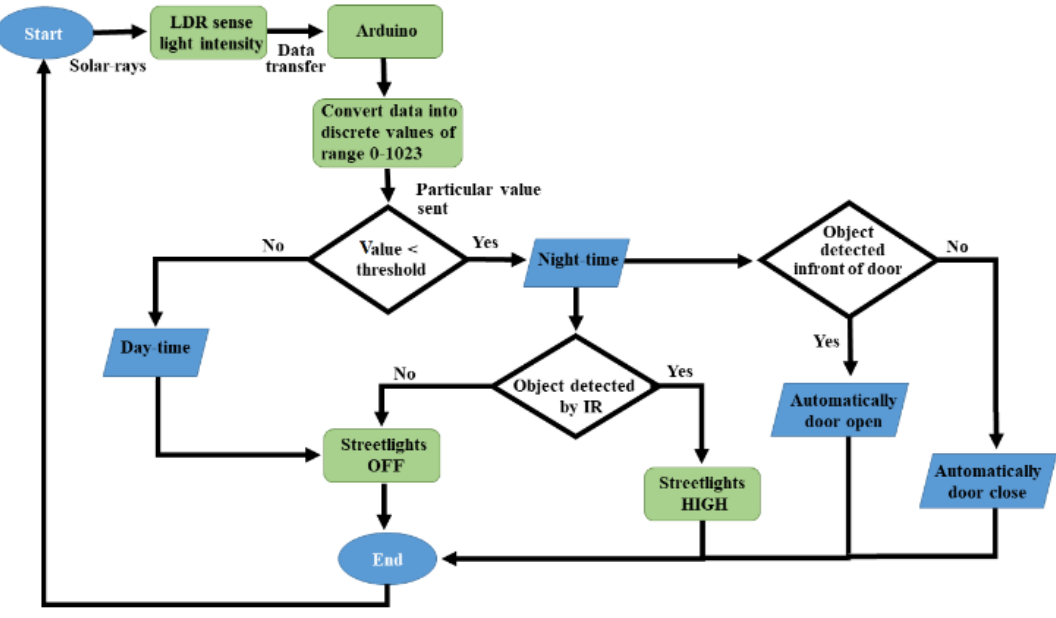
Figure 6. The flow diagram of the automation system based on object detection.